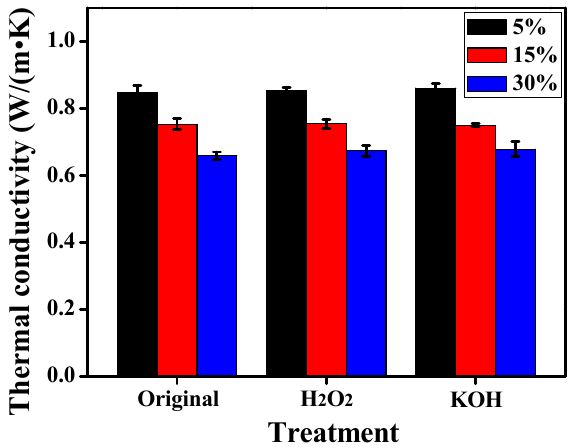
Figure 12. Thermal conductivity of the original and modified silicone rubber mortar